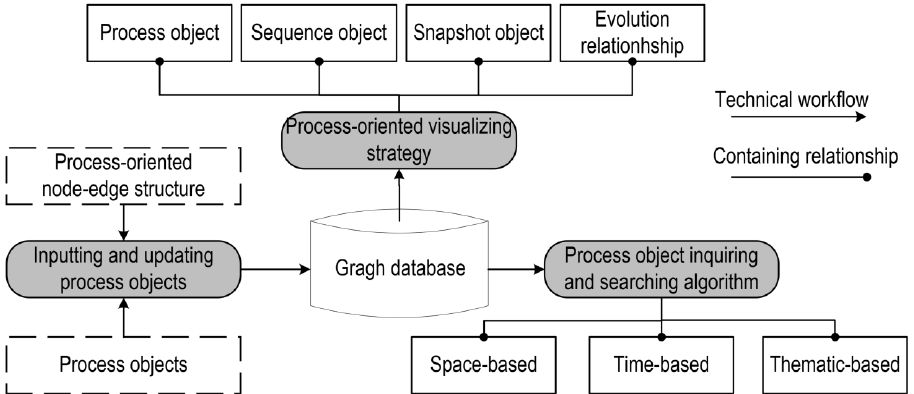
Figure 6. Workflow of building a process-oriented graph database, as well as its management and visualization.